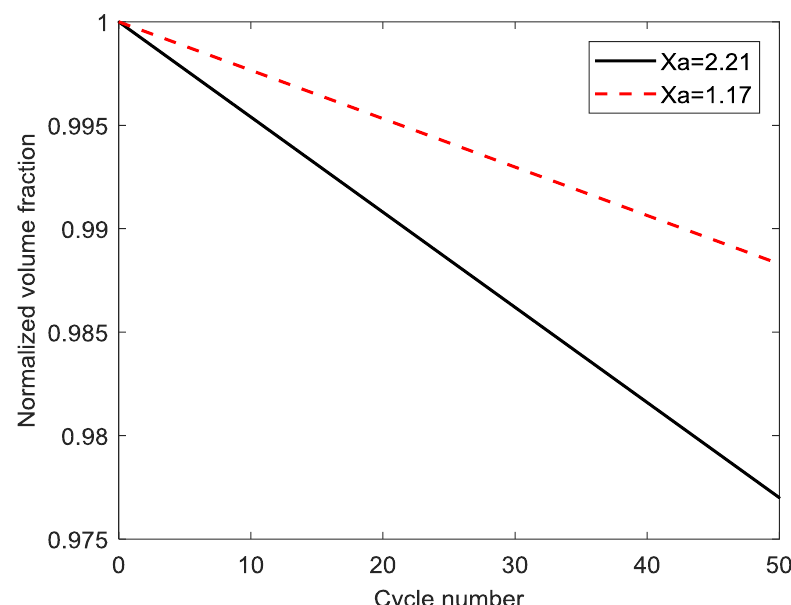
Figure 9. Normalized volume fraction change with different Mn dissolution rates ( a